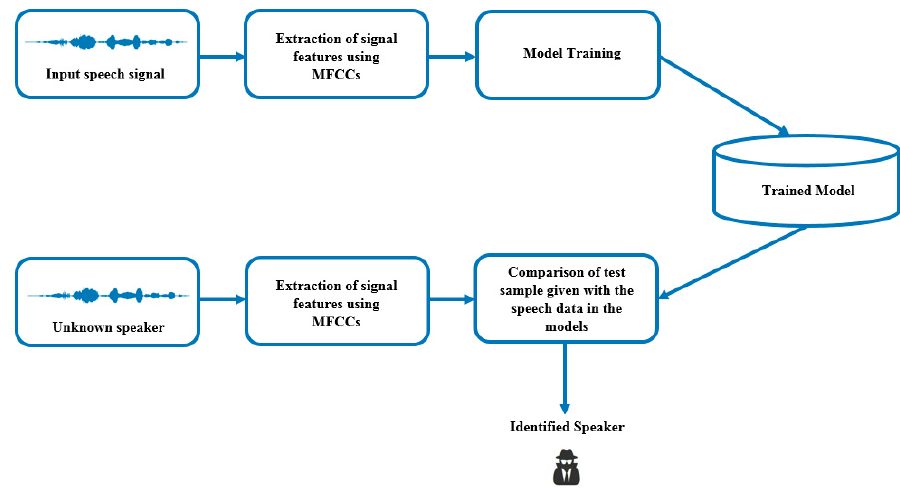
Figure 1. Speaker identification